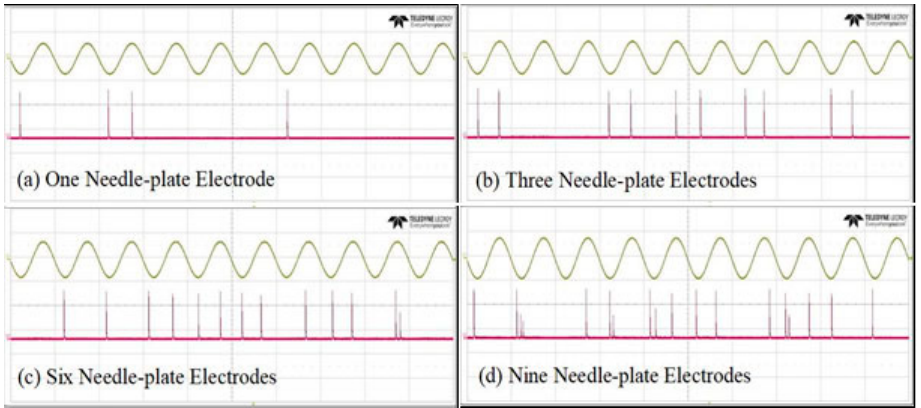
Figure 16. UV pulses under different numbers of needle-plates (D = 3 cm, L = 15 cm, U = 5 kV).